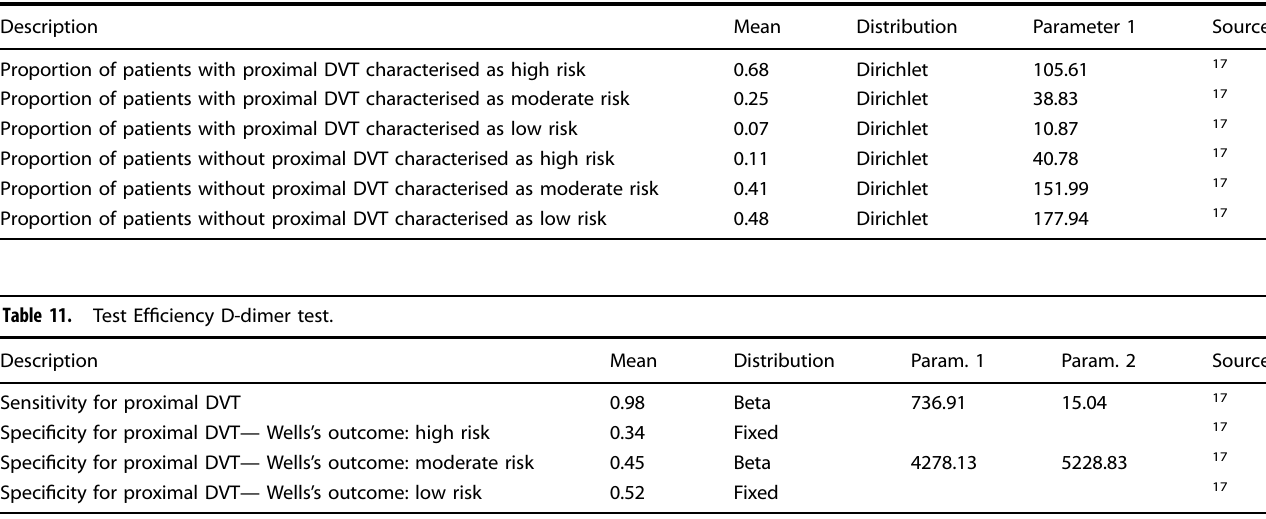
Table 10. Test Ef fi ciency Well ’ s